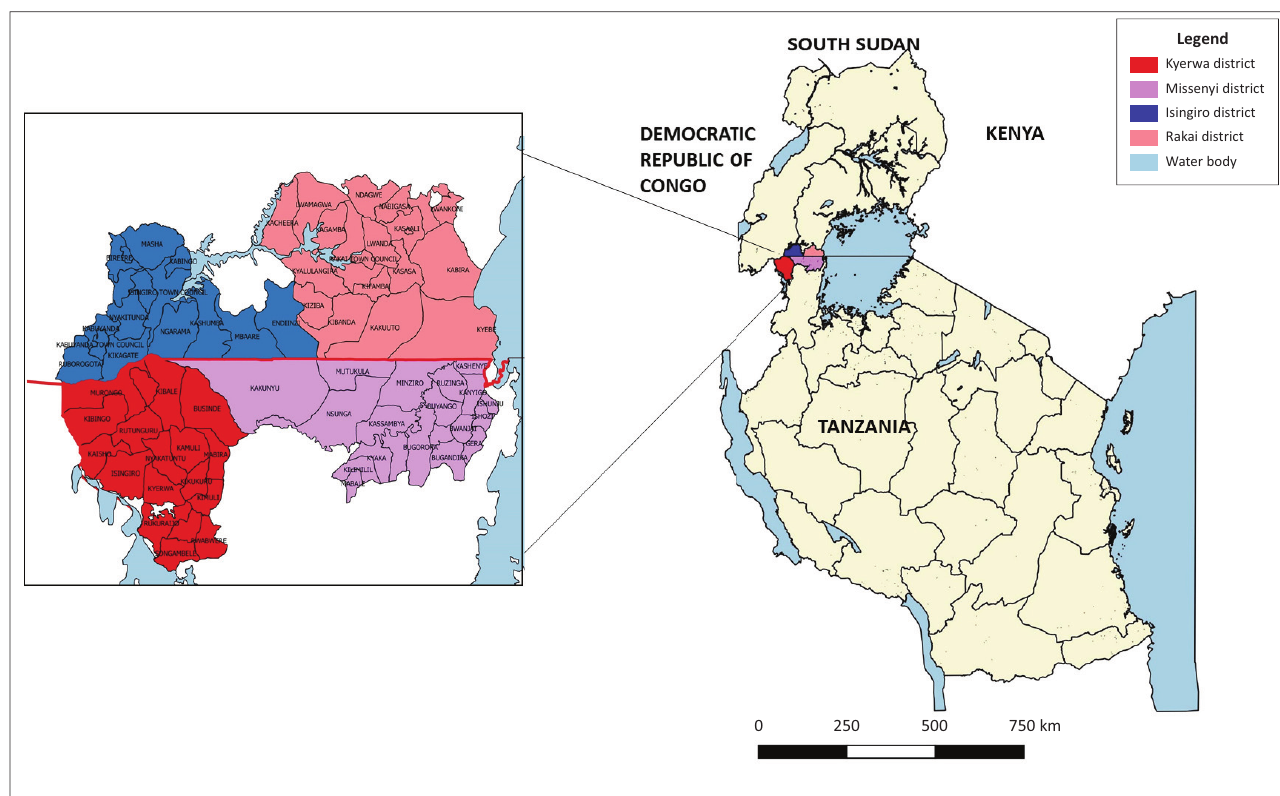
FIGURE 1: Study areas Isingiro and Rakai districts in Uganda and Missenyi and Kyerwa districts in